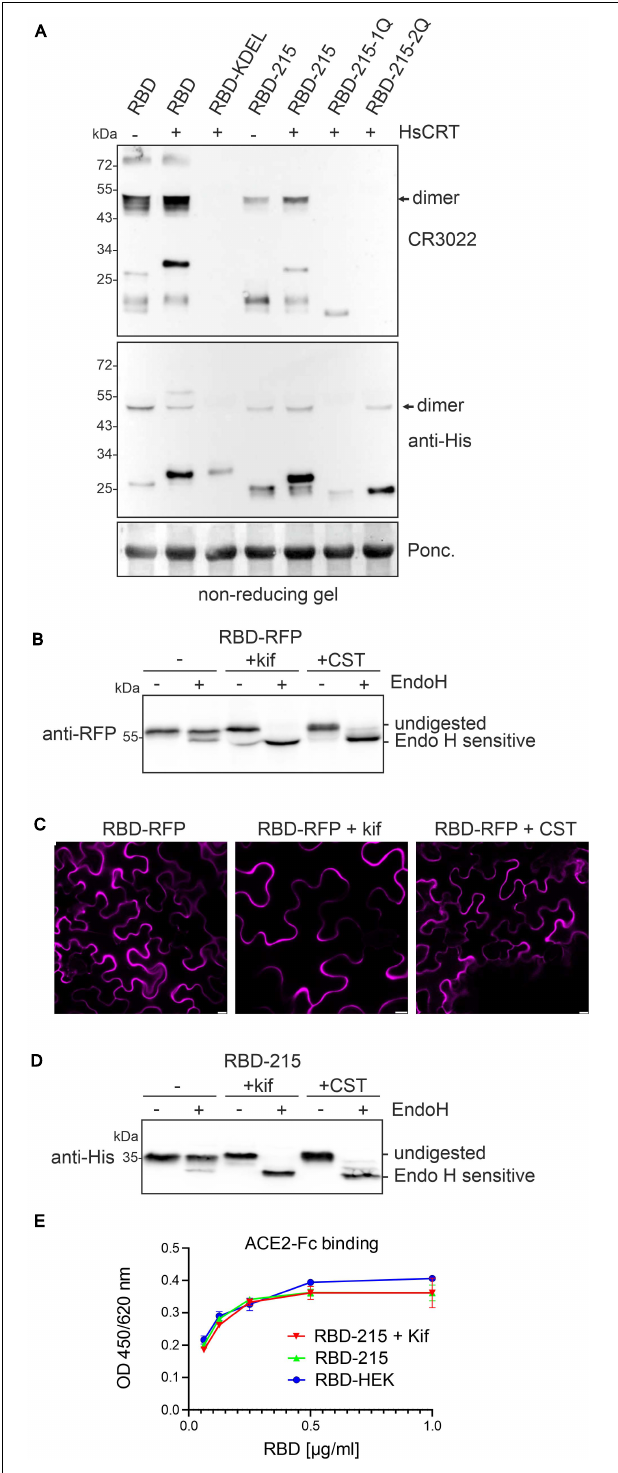
FIGURE 6 | Human CRT has only a minor effect on folding of aberrant RBD variants. (A) The indicated RBD variants were expressed with or without HsCRT, crude protein extracts were subjected to SDS-PAGE under non-reducing conditions and analyzed by immunoblotting with anti-His